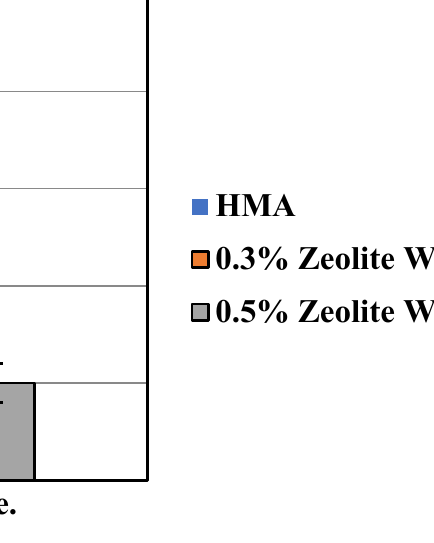
Figure 5. Marshall Flow results. 3.2. Resilient Modulus Test (M r ) Results Figure 6 displays the findings of the resilient modulus values for the 12 prepared cylindrical specimens, which are tested at four test temperatures (20, 25, 30, and 40) °C subjected to a haversine waveform of 1 Hz frequency which has 0.1 s loading duration and 0.9 s rest period. As seen in the figure, a temperature rise has a considerable impact on the resilient modulus. The findings show that the WMA mixtures of two percentages of zeolite have the lowest value of resilient modulus, whereas the HMA mixture has a